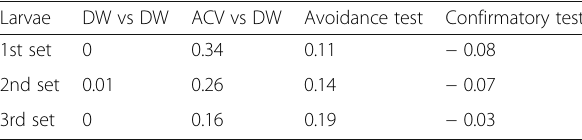
Table 3 Culture of flies in 1.0 ppm NaF in four different bottles